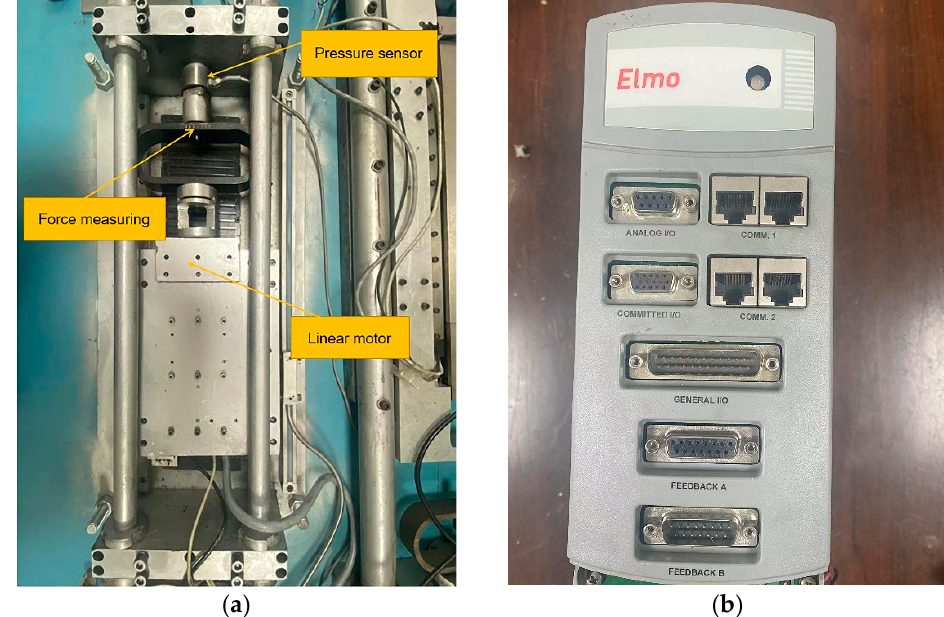
Figure 13. PMLSM experimental platform: ( a ) Motor overall and force measuring device; ( b ) drive.